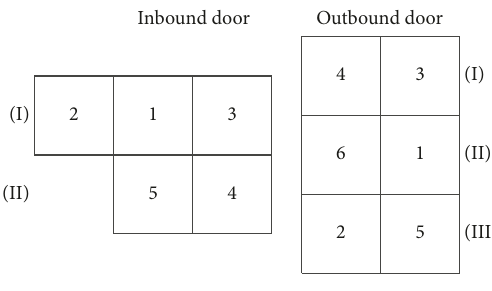
Figure 4: Sequences of